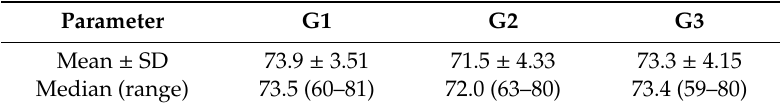
Table 1. Mean, standard deviation (SD) and median of removal torque values measured for each group in Newton per centimetre (Ncm). G: group